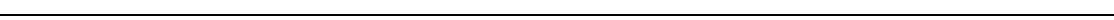
Fig. 5 Tet1 and Tet2 control miRNA secretion in BMMSCs through demethylation of P2rX7 . a Bradford assay showed exosome secretion in control and Tet DKO BMMSCs. Exosomes from the culture supernatant of 1 × 10 6 BMMSCs containing proteins were assessed. b Western blotting showed exosomes from control and Tet DKO BMMSCs expressed CD9 and CD81. Exosome proteins from equal volumes of culture supernatant of WT and Tet DKO BMMSCs